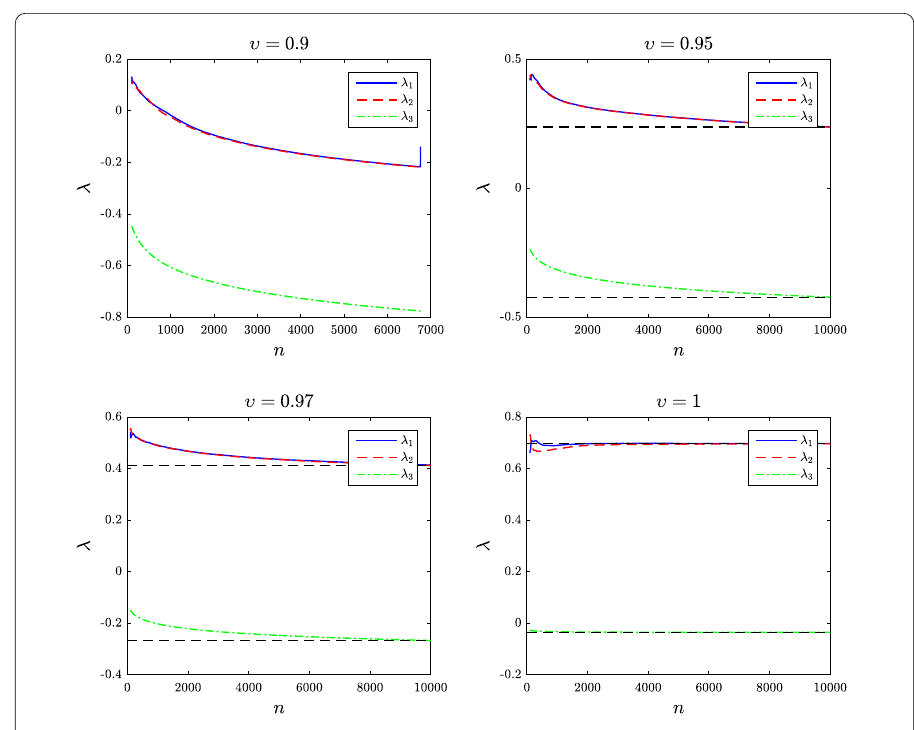
Figure 13 Estimated Lyapunov exponents of the fractional Rössler map for with ( b 2 , b 3 , b 4 , b 5 , b 6 , b 7 ) = (0.05,0.35,3.78,0.2,0.1,1.9), ( x (0), y (0), z (0)) = (0.1,0.2,–0.5), and different fractional orders